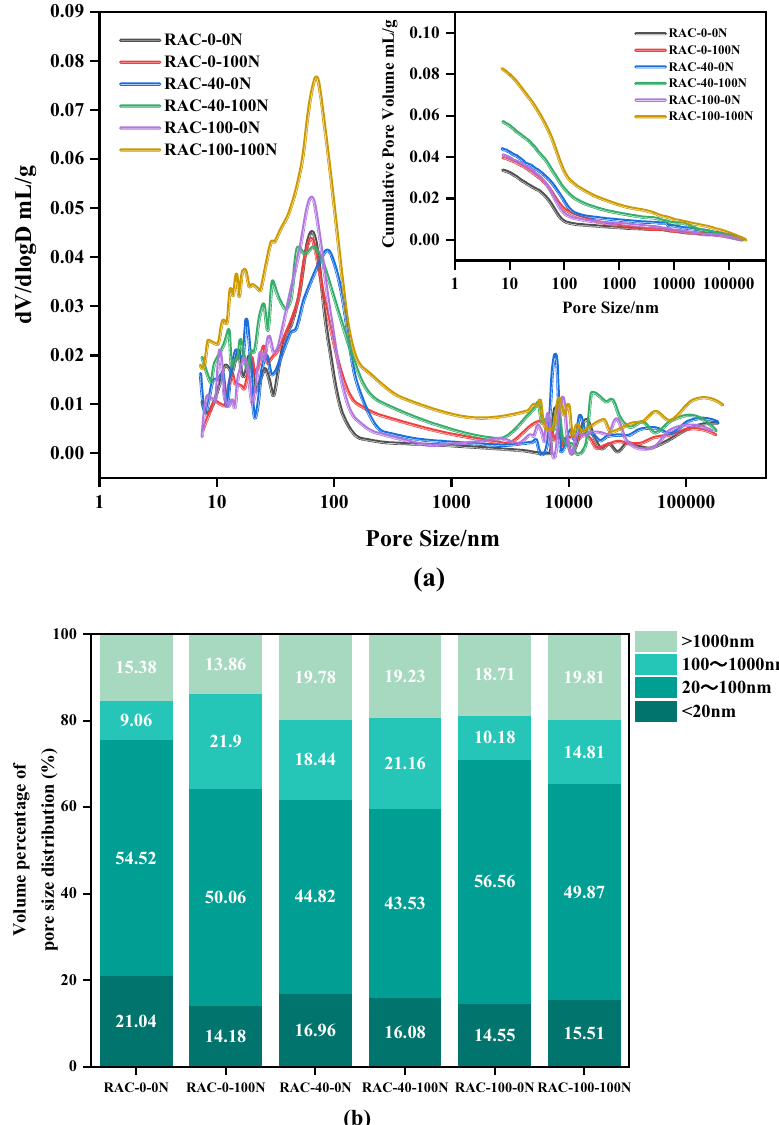
Figure 9: Pore structure distribution of RC for after salt - frost cycles: ( a ) pore size distribution; ( b ) cumulative pore volume percentage.